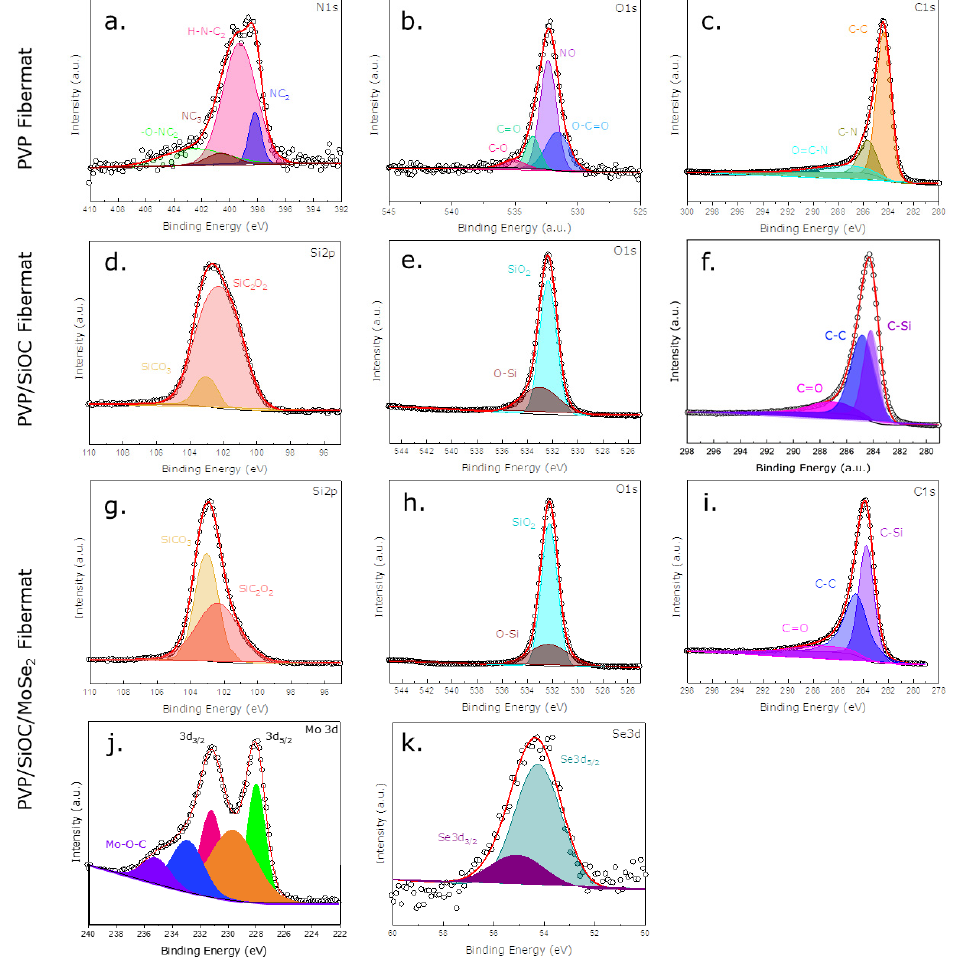
Figure 6. High-resolution XPS spectra of three pyrolyzed fiber mats: ( a – c ) PVP fiber mat; ( d – f ) PVP/SiOC fiber mat; ( g – k ) PVP/SiOC/MoSe 2 fiber mat. Figure 7a–c illustrates the FTIR absorption bands of the PVP, PVP/SiOC, and PVP/SiOC/MoSe 2 fiber mats in their as spun, cross-linked, and pyrolyzed forms. From the FTIR spectra of the as-spun PVP fiber mat, absorption bands at 570, 841, 1018, 1288, 1422, 1663, 2923, and 3399 cm − 1 were observed. These peaks can be assigned to N-C=O bond bending, CH 2 bond bending, the rocking motion of CH 2 bonds, C-N bond stretching, C-H bond stretching, C=O bond stretching, and symmetric stretching of the CH 2 chain, respec-